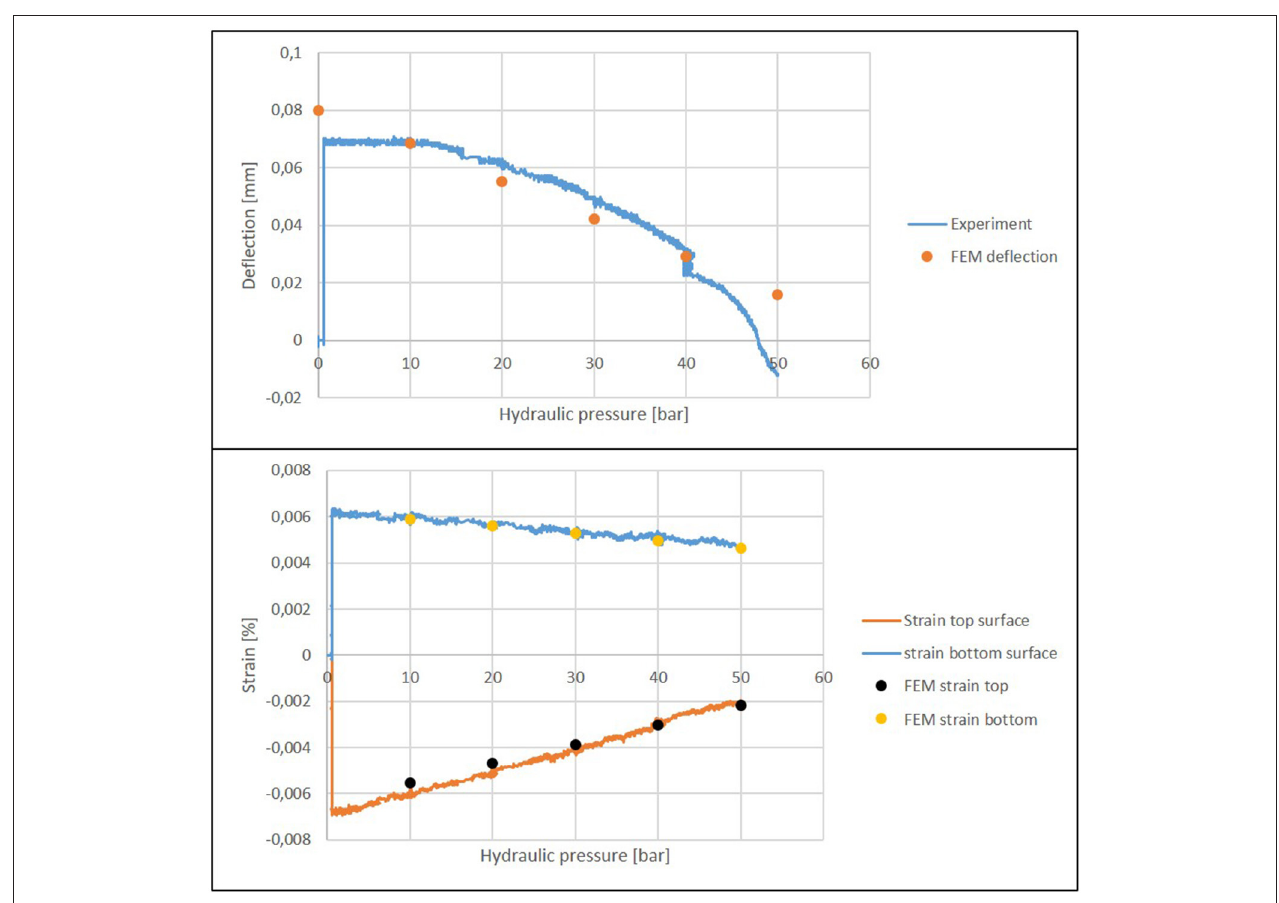
FIGURE 14 | Compensation of the deflection (Top) and strains (Bottom) as a result of hydraulic